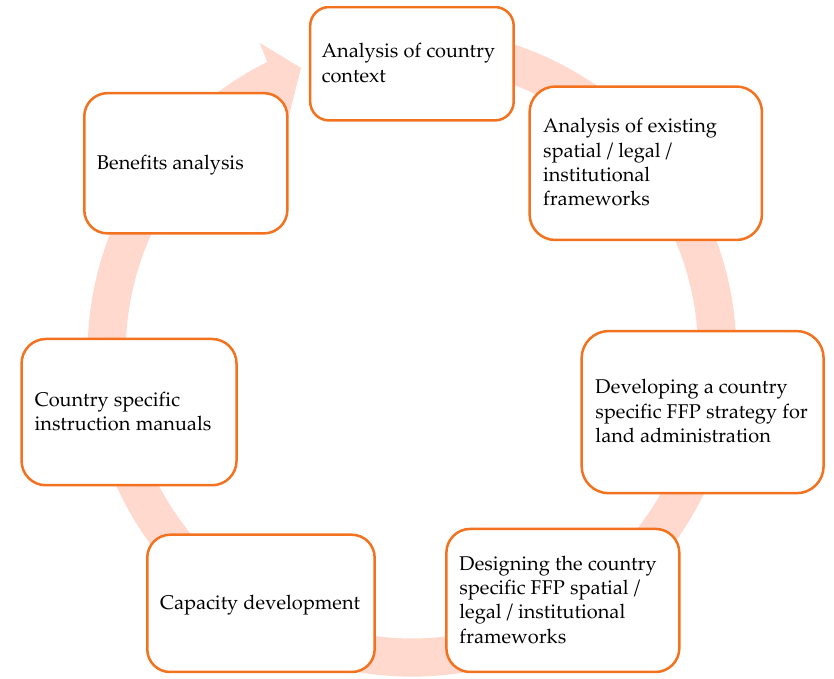
Figure 1. Country-level FFP implementation approach [22]